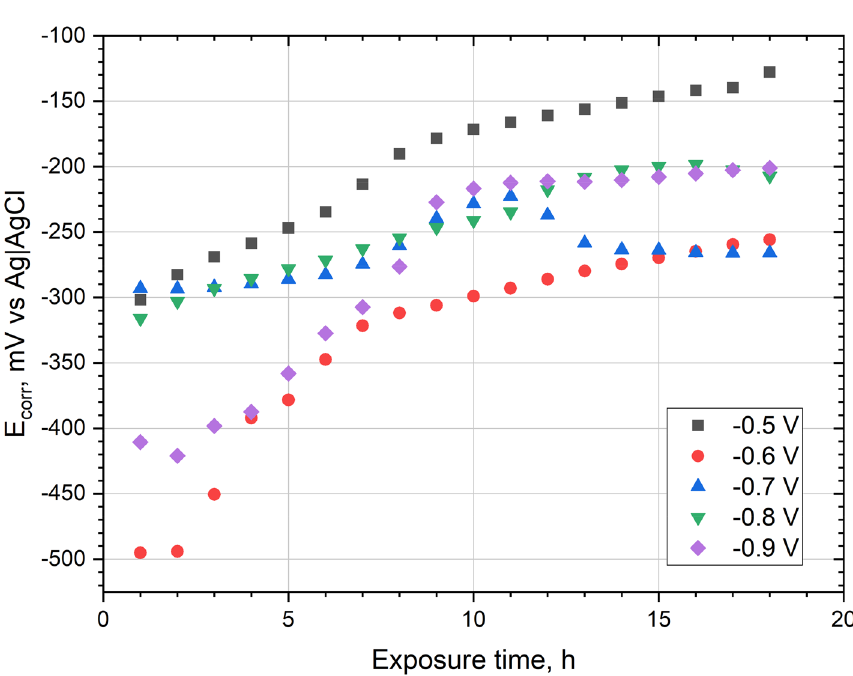
Figure 10. Corrosion potential (E corr ) recorded during 18 h of exposure in 0.05 mol dm −3 deaerated NaCl solution of Ni–Mo